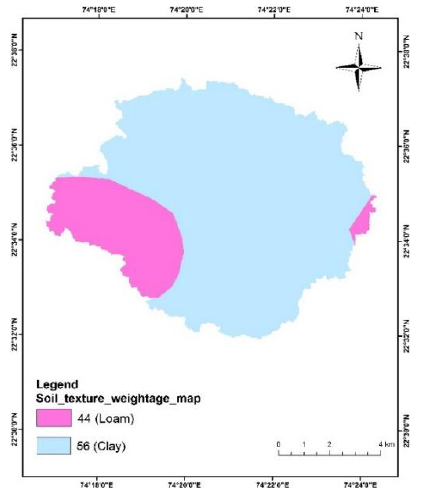
Figure 7. Soil Texture Weightage Map